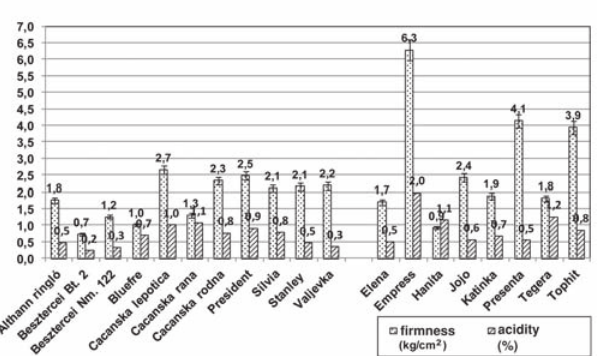
Figure 5. Mean fi rmness and content of titrable acid content of plum fruits with the standard error of measurements